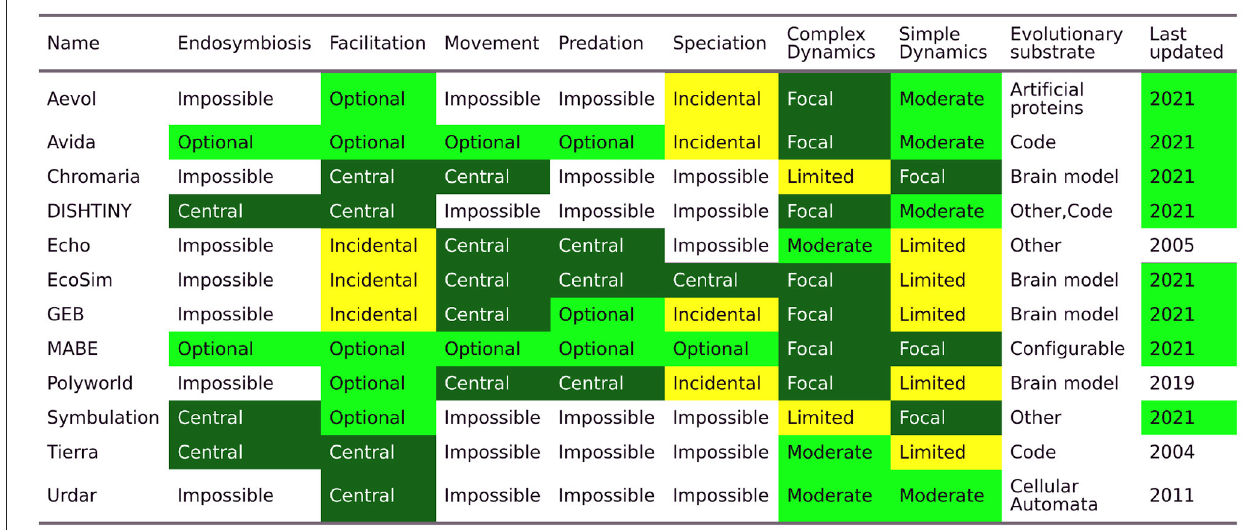
FIGURE 3 | Comparison of digital evolution platforms. This table rates digital evolution platforms on the extent to which they can be used to study specific dynamics. A rating of “central” indicates that a dynamic is a critical component of a system and has likely been studied in that system. A rating of “optional” indicates that the dynamic is not present by default but can be turned on. A rating of “incidental” indicates that the dynamic may occur in the system, but likely not in a particularly straightforward way. A rating of “impossible” indicates that a dynamic is excluded from that system, as it currently exists. The speciation rating specifically refers to speciation in the context of sexual recombination. The “Complex Dynamics” and “Simple Dynamics” columns reflect each system’s position along the continuum in Figure 1 . “Complex Dynamics” indicates the extent to which the system supports dynamics toward the rich and natural end of the spectrum. “Simple Dynamics” indicates the extent to which the system supports being configured to be simple and tractable. Note: Endosymbiosis is rated "central" to Tierra, due to the ubiquitous evolution of parasites. However, these parasites are unconventional in that they do not disproportionately harm the